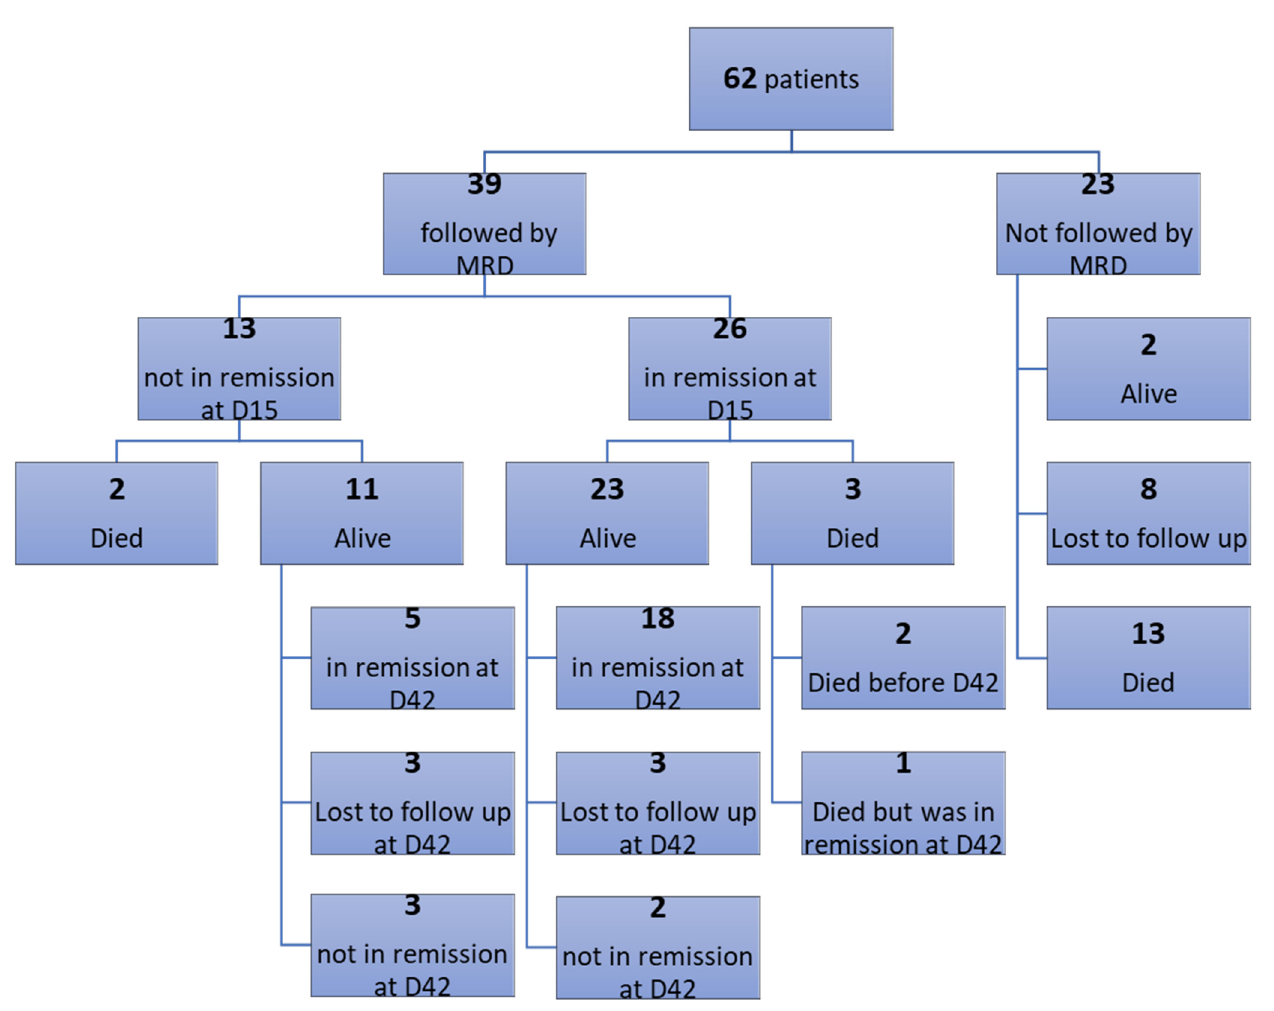
Figure 2. Algorithm follow-up of the cases.